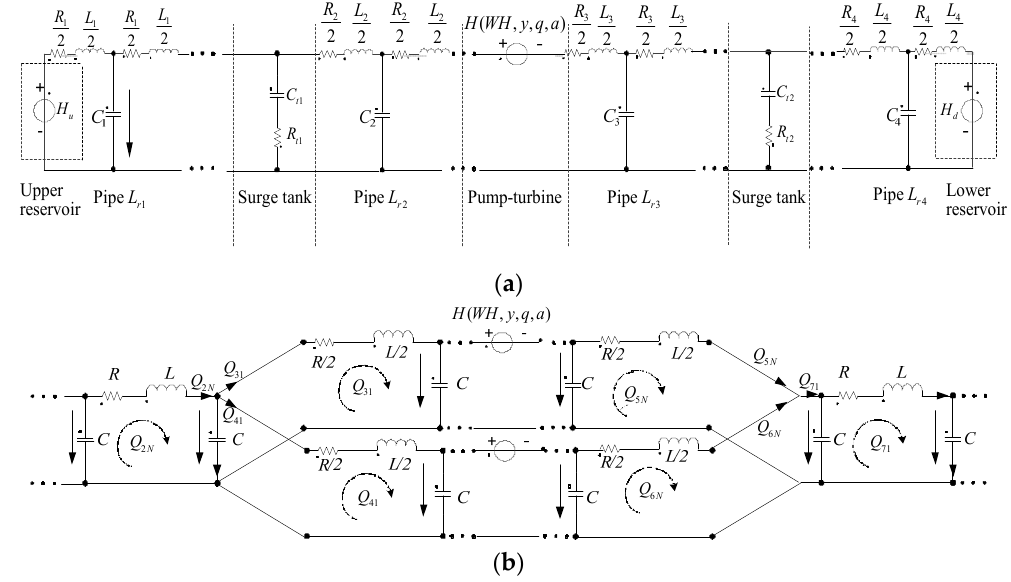
Figure 3. Topology diagram of the full pipeline system: ( a ) Single tube-single unit; ( b ) single tube-double